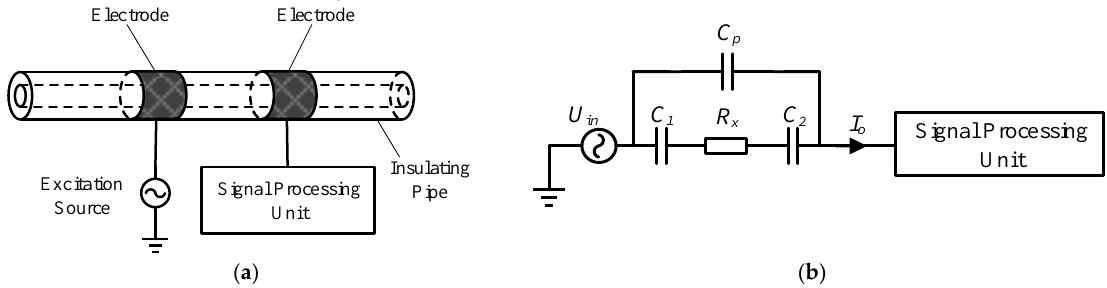
Figure 1. C 4 D sensor: ( a ) The typical construction; ( b ) The equivalent circuit.